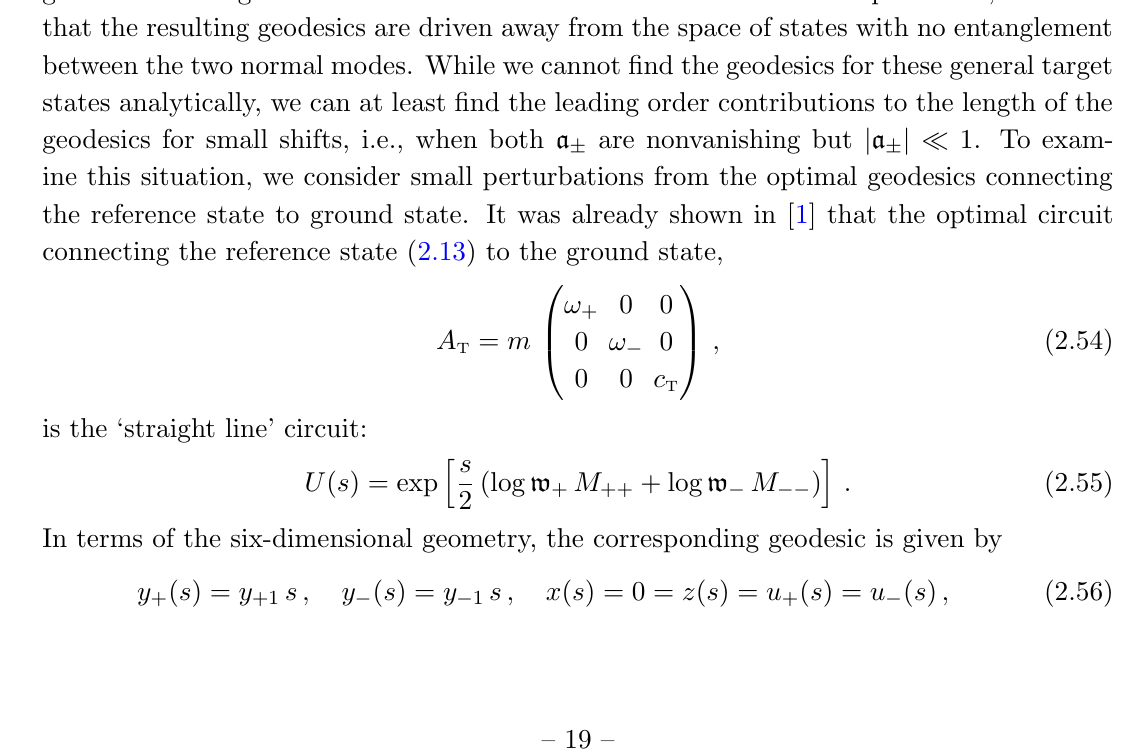
Figure 5 . A comparison of the lengths of the optimal geodesic and the \simpler" geodesic with z 1 = 0. (cid:1) k = k sim (cid:0) k opt and k opt are shown as functions of (cid:3) (cid:0) ( s = 1) = (cid:0) m! + example is characterized by the boundary conditions y +1 = 0 : 1 ; y (cid:0) 1 = 1 : 1 and (cid:3) +1 = 1 : 105, while (cid:3) (cid:0) ( s = 1) varies from 0 to 12.017. We note that while (cid:1) k grows as j a (cid:0) j increases, it represents at most an increase of 0 : 2% over k opt for the geodesics shown